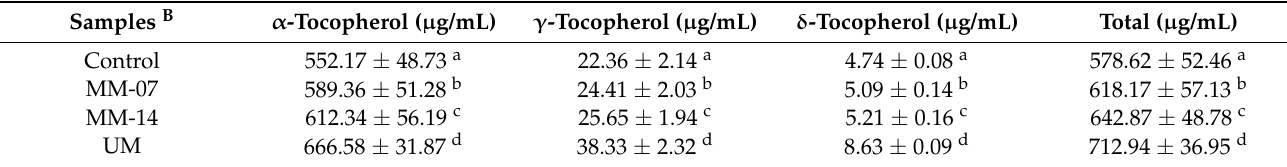
Table 3. The contents of tocopherols in SFO samples A .